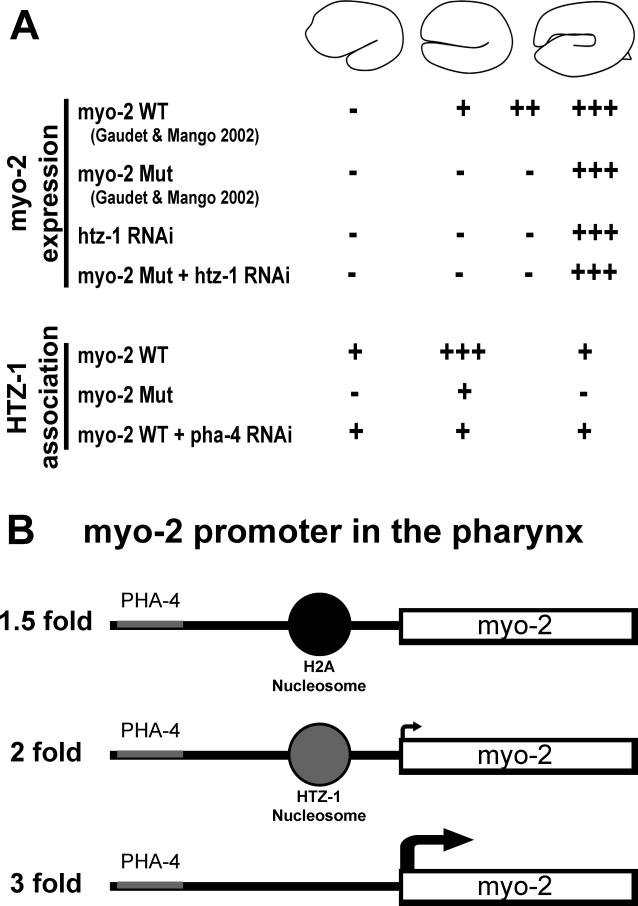
Summary and Model: HTZ-1 Synergizes with PHA-4 to Establish the Foregut(A) Summary of the data presented in this paper and in [18]. myo-2 expression initiates at the 2-fold stage, and onset at this stage requires pha-4 and htz-1 because mutation of PHA-4 binding sites (Mut) or htz-1 RNAi lead to a delay in myo-2 activation. HTZ-1 association with the myo-2 promoter peaks at the onset of myo-2 transcription, and this association requires pha-4.(B) Model to explain how HTZ-1 synergizes with PHA-4. PHA-4 association with the myo-2 promoter leads to exchange of H2A-containing nucleosomes for one or more nucleosomes carrying HTZ-1/H2A.Z at the 2-fold stage. Based on data from other organisms [1], we propose MYS-1 and/or SSL-1 function in a complex that performs the exchange reaction. HTZ-1–containing nucleosomes promote transcriptional activation by the 2-fold stage.